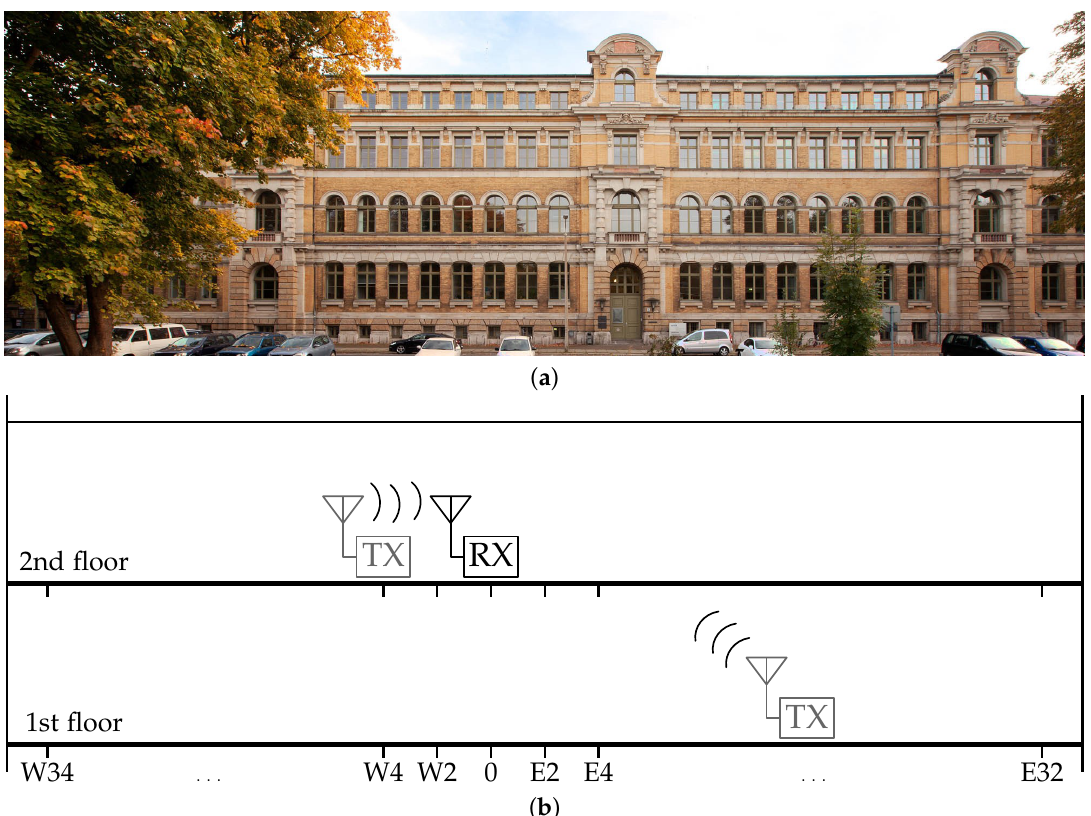
Figure 20. Setup of indoor range test. ( a ) Range test at the Faculty of Engineering of HTWK Leipzig (credit: Swen Reichhold/HTWK Leipzig); ( b ) Schematic side view of the measurement